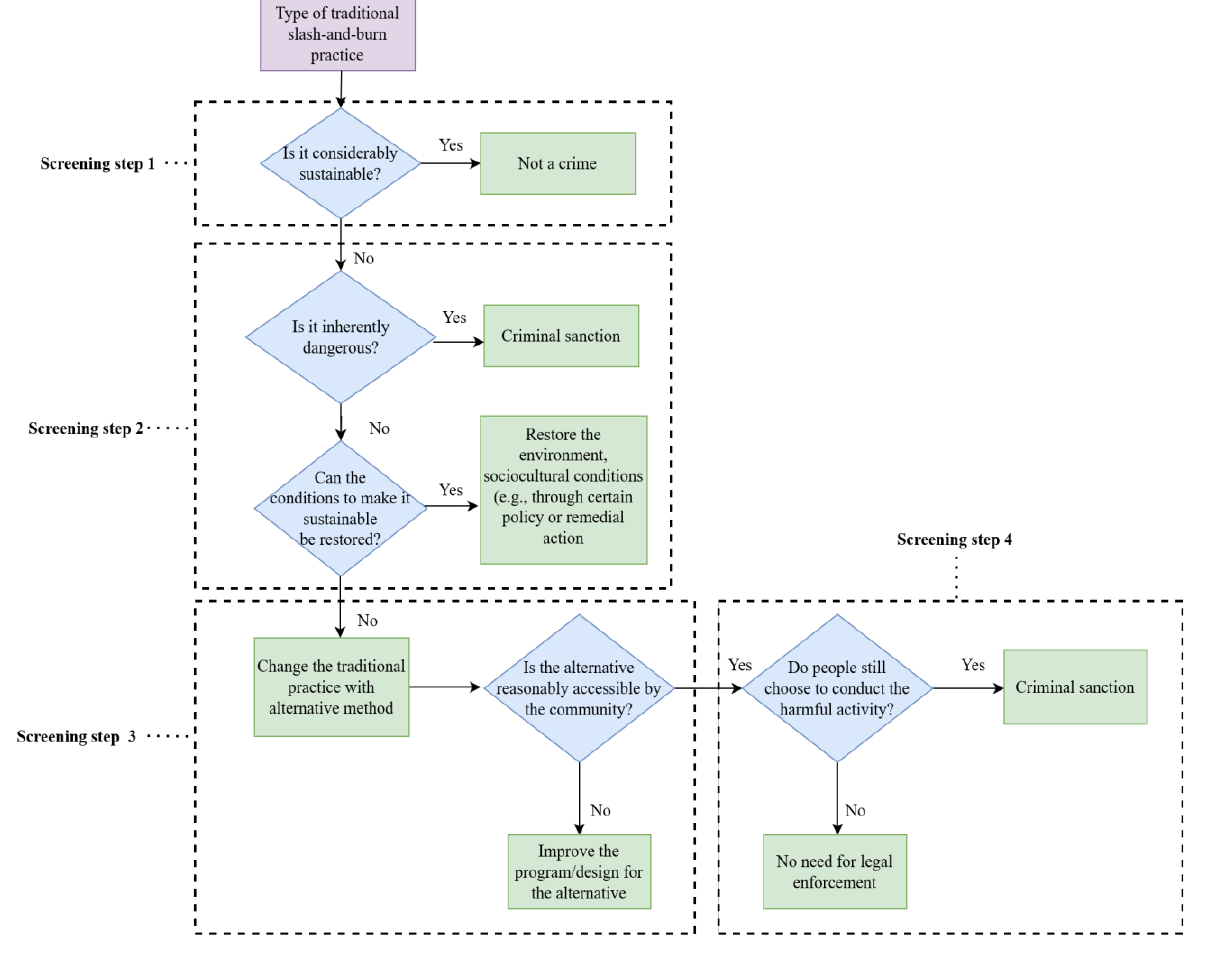
Figure 1. The screening process and actions in response to harmful